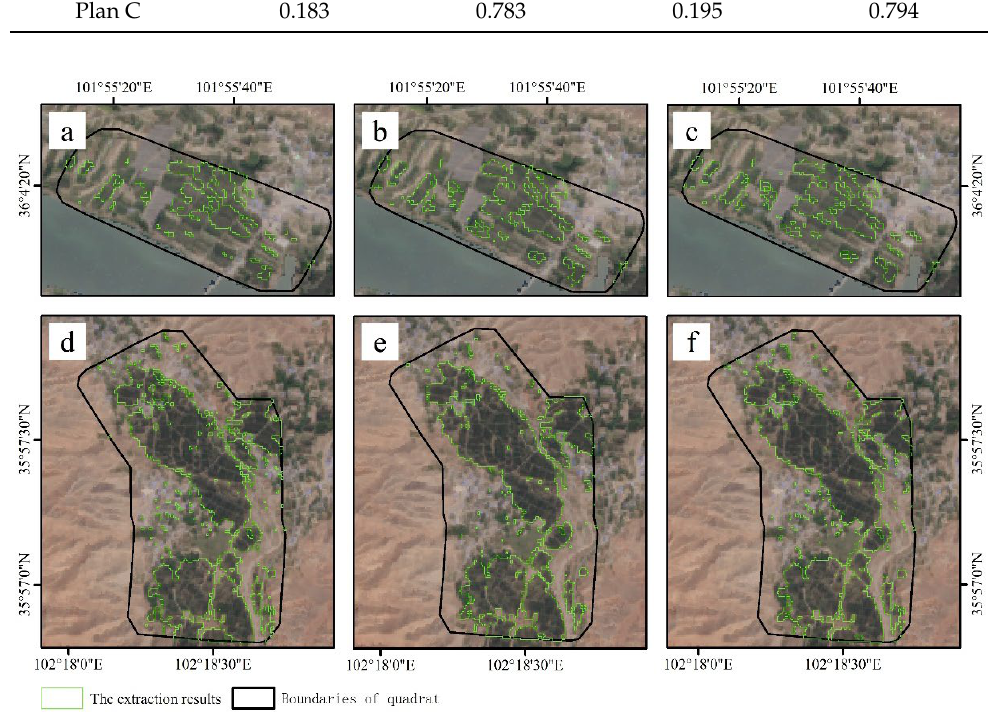
Figure 11. Results of winter wheat extraction under optimal thresholds of the two quadrats. ( a , d ) Extraction results of the overall quadrat in Plan A. ( b , e ) Extraction results of the overall quadrat in Plan B . ( c , f ) Extraction results of the overall quadrat in the Plan C .